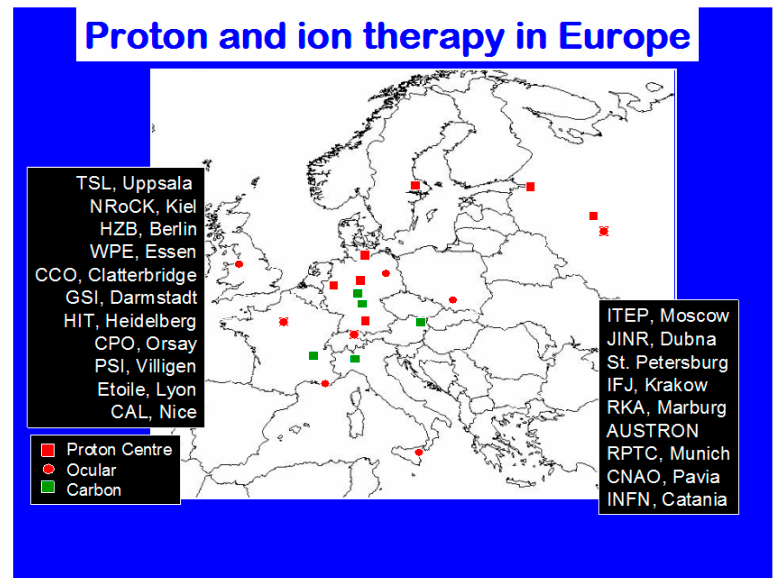
Figure 23. Proton and ion therapy centers in Europe